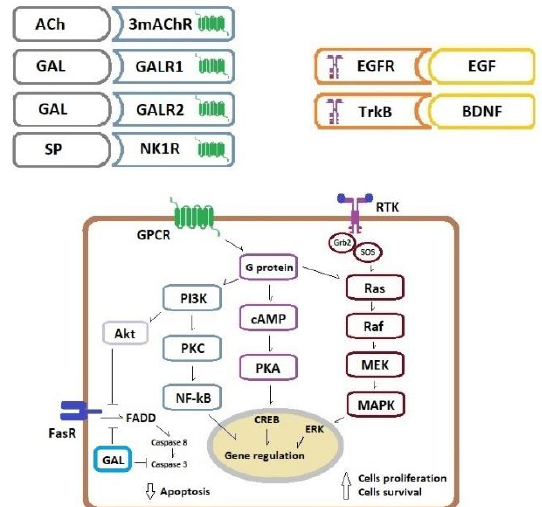
Figure 2. Schematic presentation of key pathways activated in a colorectal cancer cell by three groups of cell membrane receptors. Binding of Ach, GAL and SP to GPCRs triggers multiple transduction pathways which promote cell proliferation and survival, binding of EGF and neutrophins to the RTKs promotes cell proliferation whereas binding of FasR ligands activates extrinsic pathway of apoptosis.